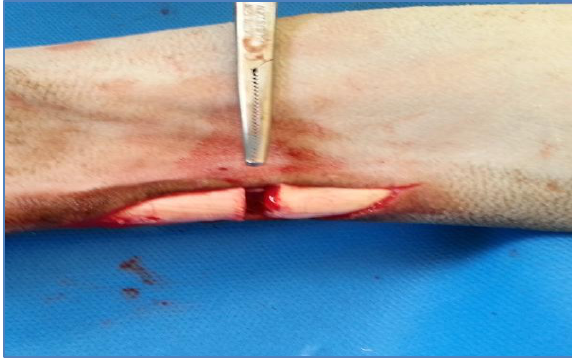
Figure, 2: Achilles tendon is transected in its mid